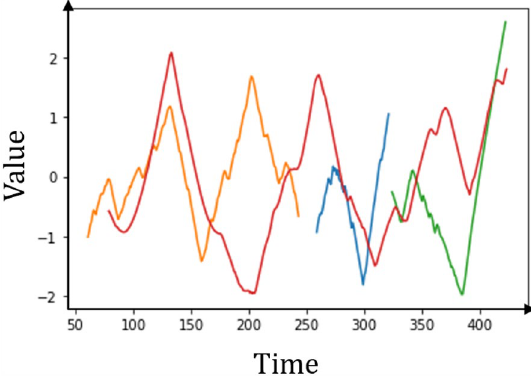
Figure 4. Multiple shapelets extracted from OSULeaf.